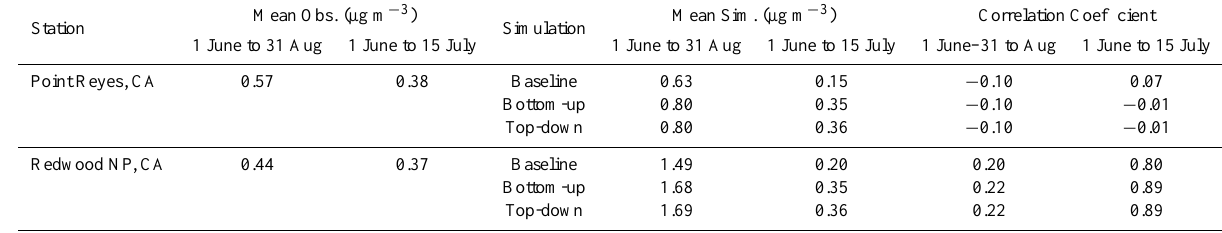
Table 1. Comparison between simulated and observed organic carbon aerosol concentrations for two coastal IMPROVE stations during the simulation period and the period from 1 June to 15 July 2005. Station